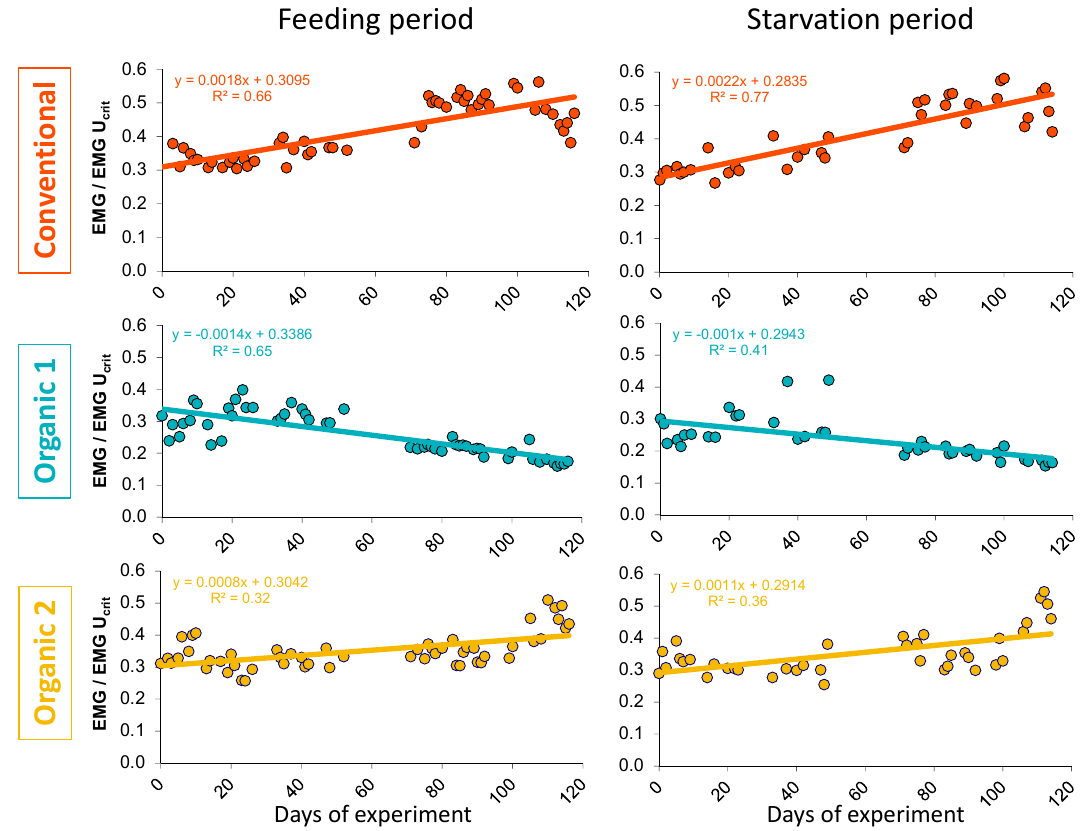
Figure 3. Mean daily red muscle activity values (EMG / EMG U crit ) during the feeding and starvation periods for the three diets (Conventional, red; organic diet 1, blue and organic diet 2, yellow). Equation and R 2 are reported for significant correlation (Spearman’s correlation, p < 0.05).